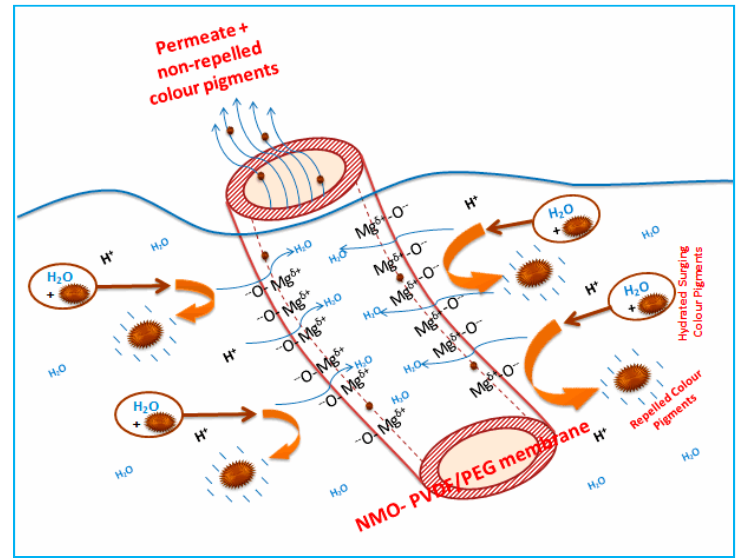
Figure 8. Schematic of color rejection and antifouling mechanism of modified Nanocomposite NMO-PVDF/PEG membranes during filtration.